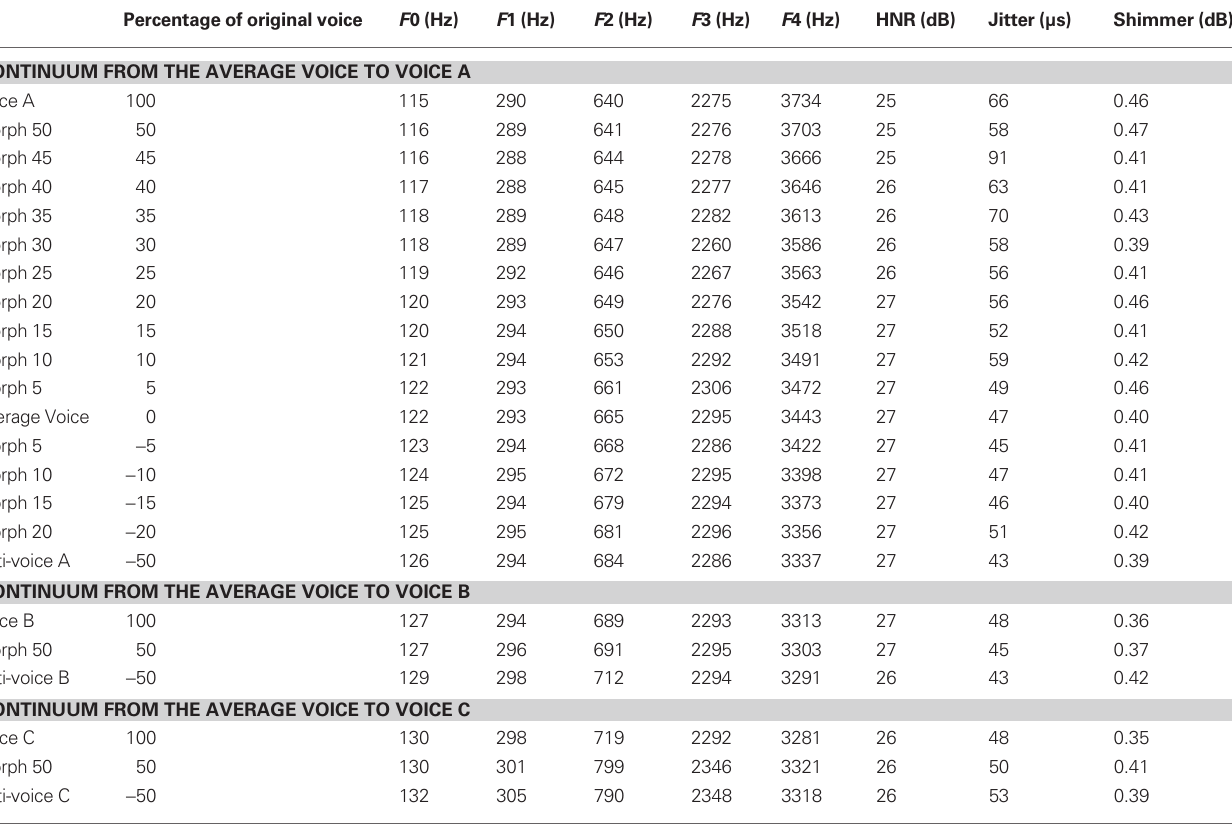
Table 1 | Acoustic parameters of the stimuli used in experiment